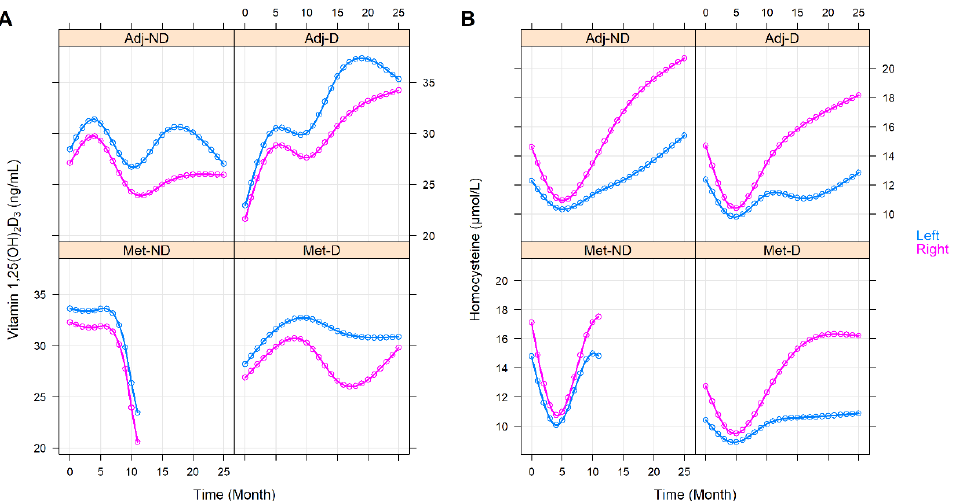
Figure 3. Predictions of average longitudinal changes in vitamin 1,25(OH) 2 D 3 ( A ) and homocysteine ( B ) level of the study groups throughout the first 25 months of the observation time, stratified by the sidedness of the tumor. Adj-ND: patients without metastasis and no vitamin D 3 supplementa- tion; Adj-D: patients without metastasis with vitamin D 3 supplementation; Met-ND: patients with metastasis and no vitamin D 3 supplementation; Met-D: patients with metastasis with vitamin D 3 supplementation.